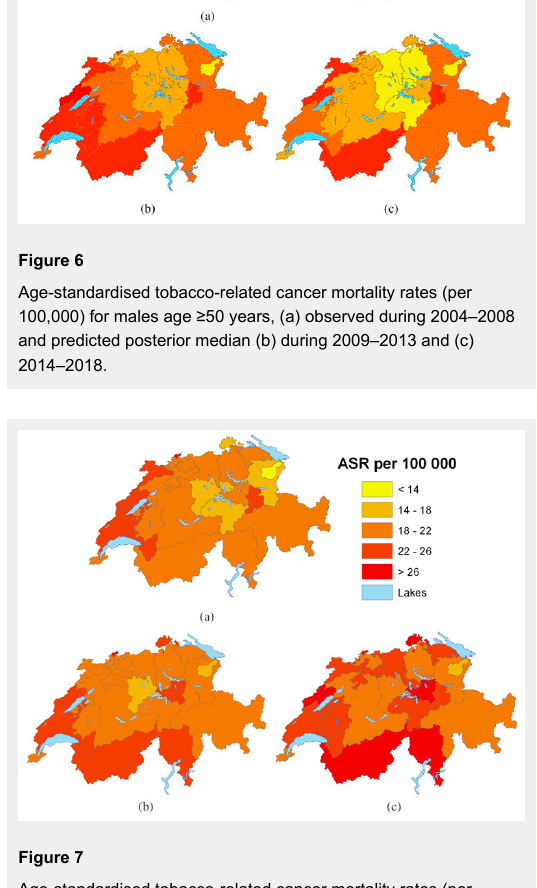
Age-standardised tobacco-related cancer mortality rates (per 100,000) for females age ≥50years, (a) observed during 2004–2008 and predicted posterior median (b) during 2009–2013 and (c)